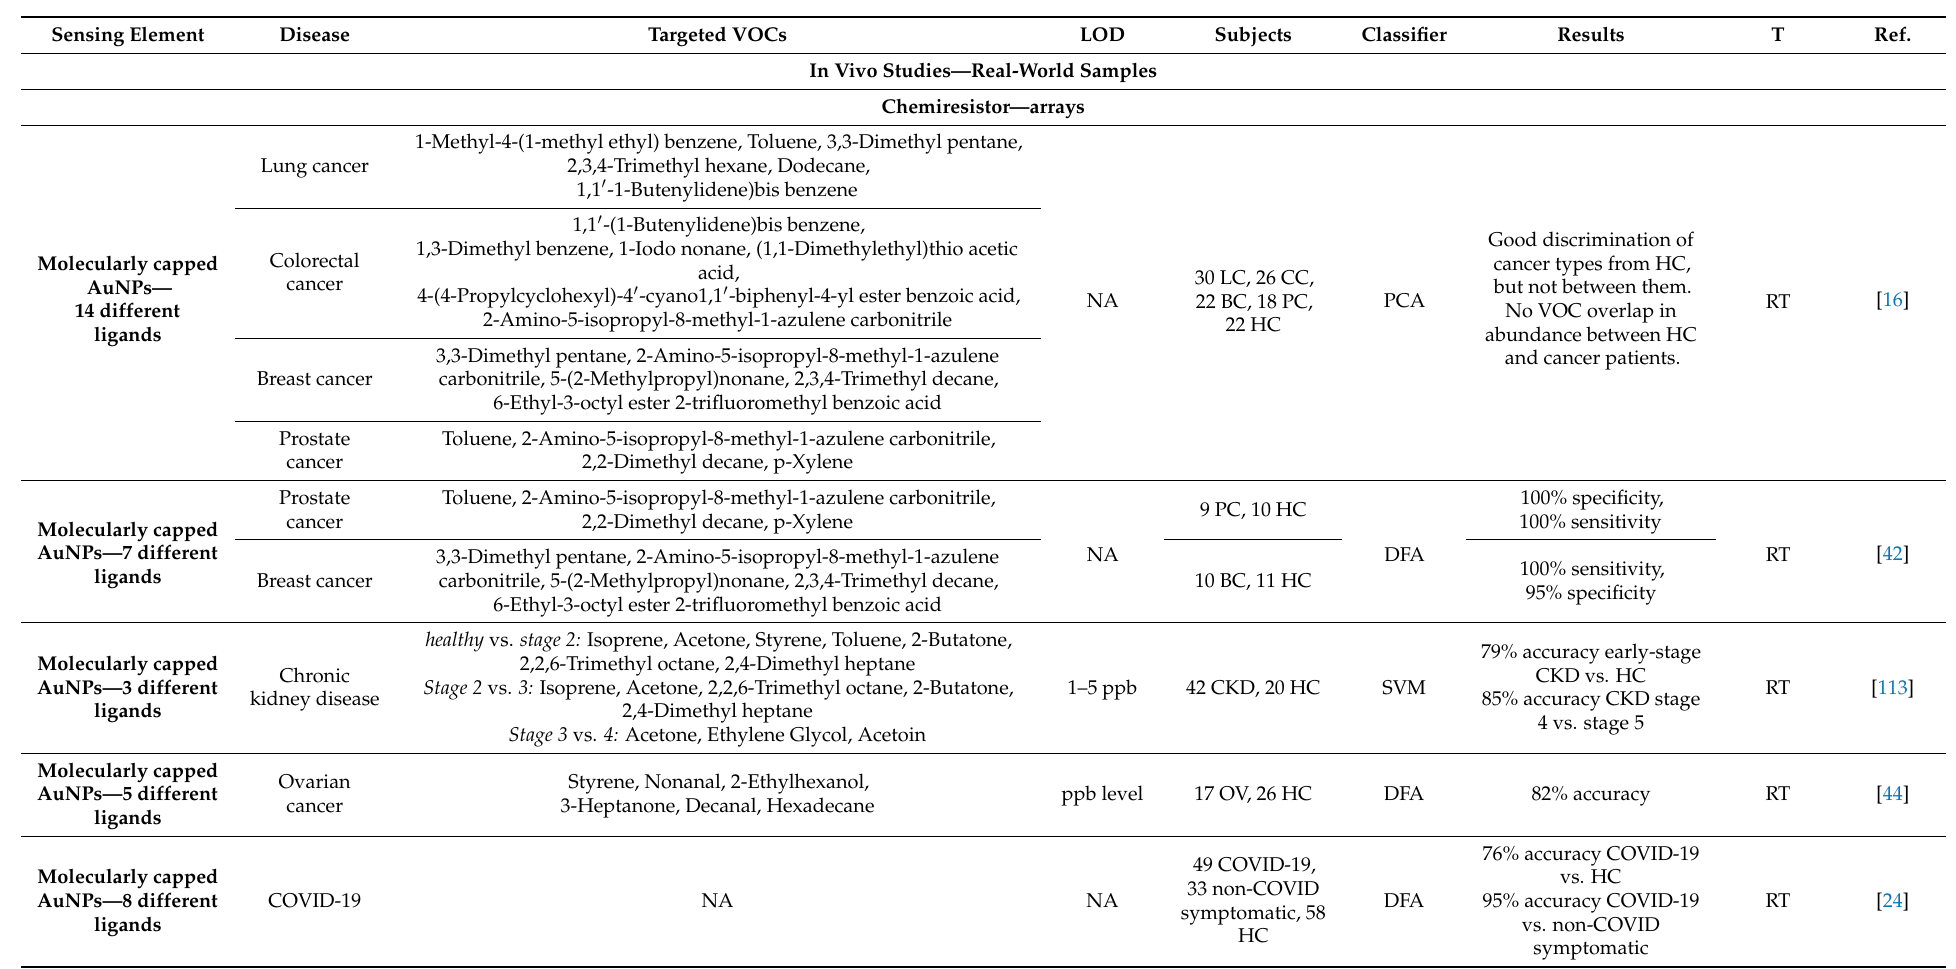
Table 2. Sensor arrays for exhaled VOCs detection as biomarkers of several diseases, in real-world or synthetic samples, using conventional materials and/ or